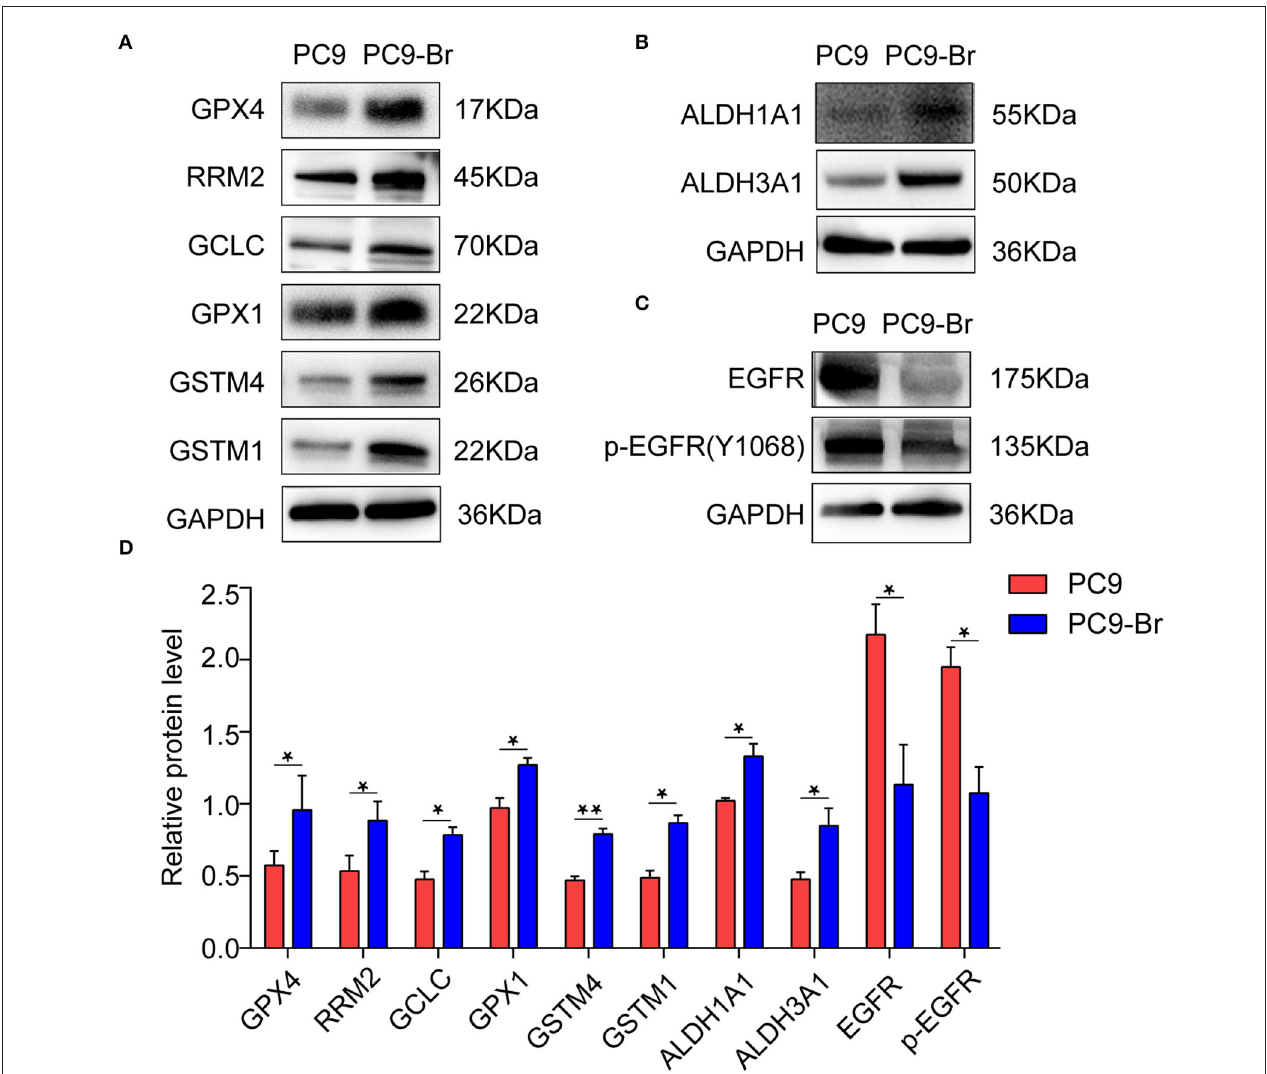
FIGURE 4 | Drug-resistance related proteins were confirmed to be regulated in PC9-Br cells. Representative western blot images showing the expression of GSH metabolism related enzymes (A) , ALDH1A1 and ALDH3A1 (B) , and EGFR/p-EGFR (C) in PC9 and PC9-Br cells. (D) Quantitative results of western blotting images for proteins. n = 3, * p < 0.05, ** p <